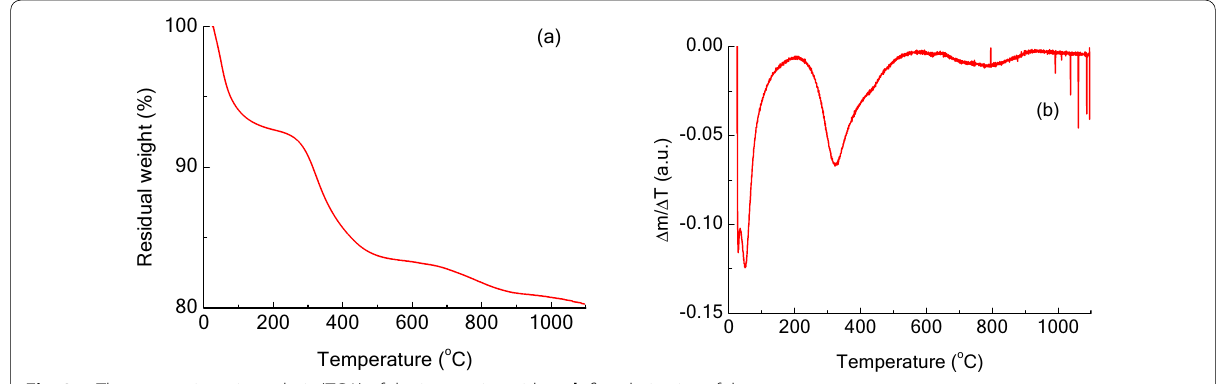
Fig. 3 a Thermogravimetric analysis (TGA) of the inorganic residues; b first derivative of the